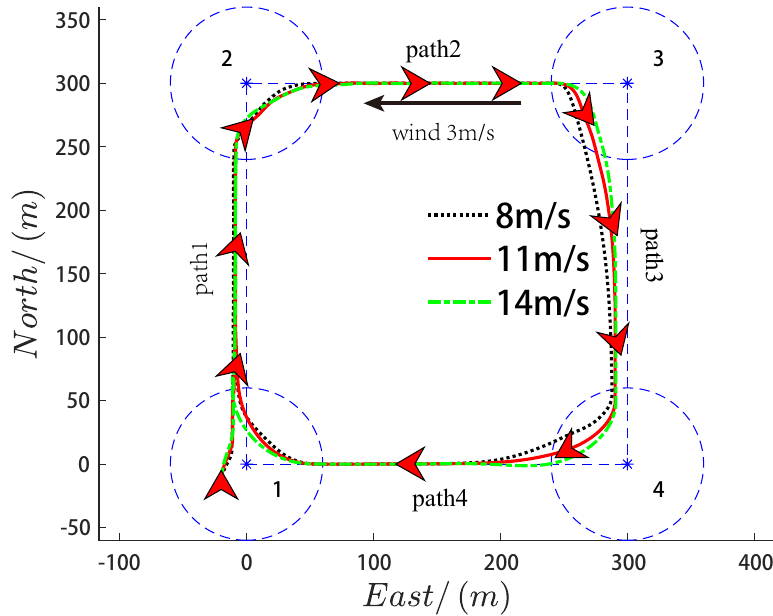
Figure 12. The flight path of the full-wing drone when tracking a four-sided path in the east